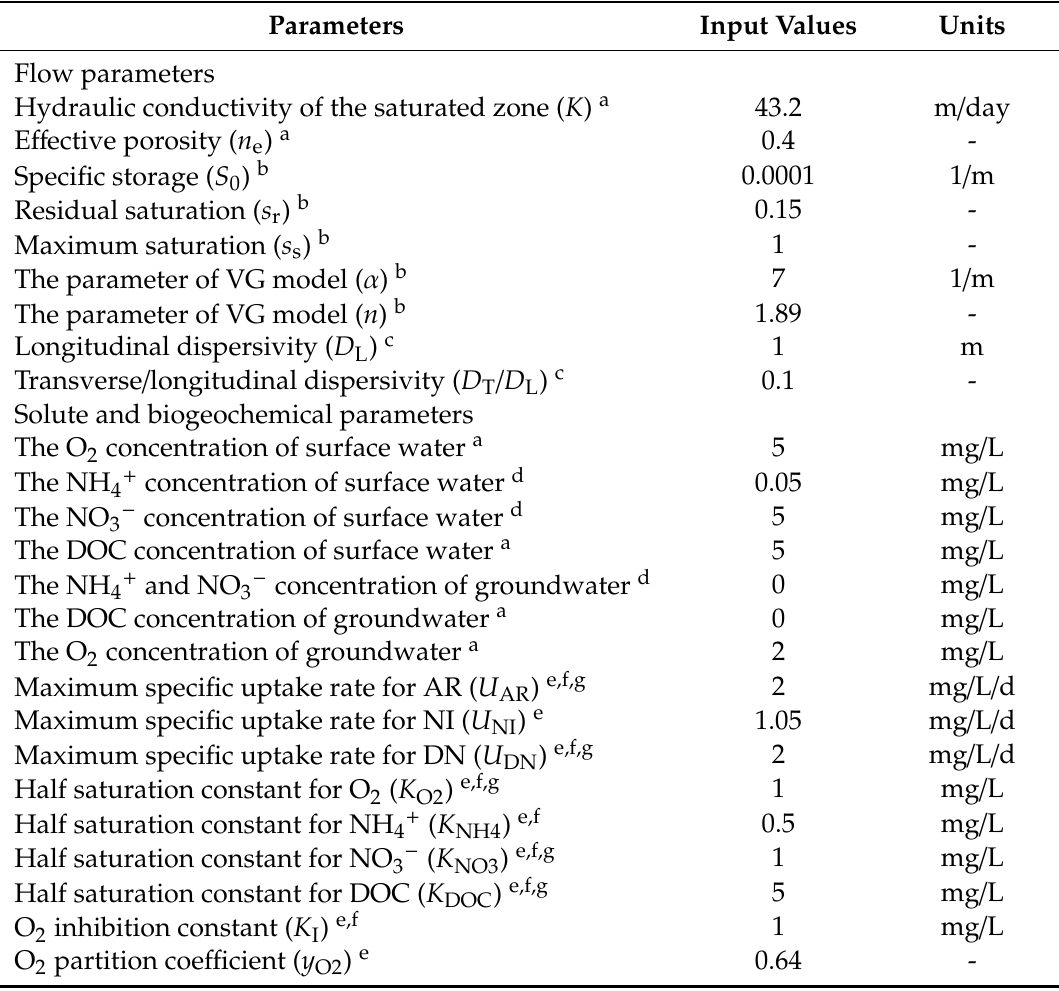
Table 3. The input parameters of the model (base